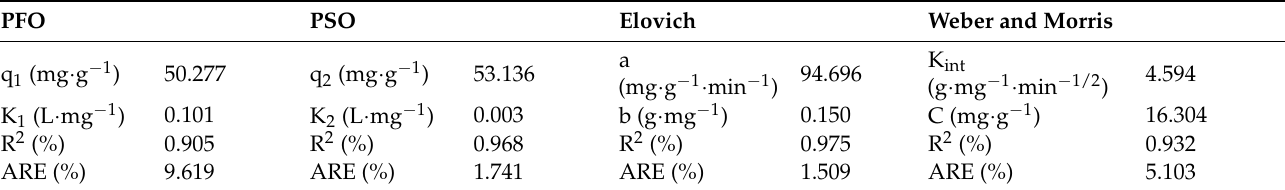
Figure 7. Kinetic curves ( a ) and intraparticle diffusion model ( b ) of Nimesulide adsorption onto ACOP. Table 4. Kinetic parameters for the Nimesulide adsorption onto ACOP.